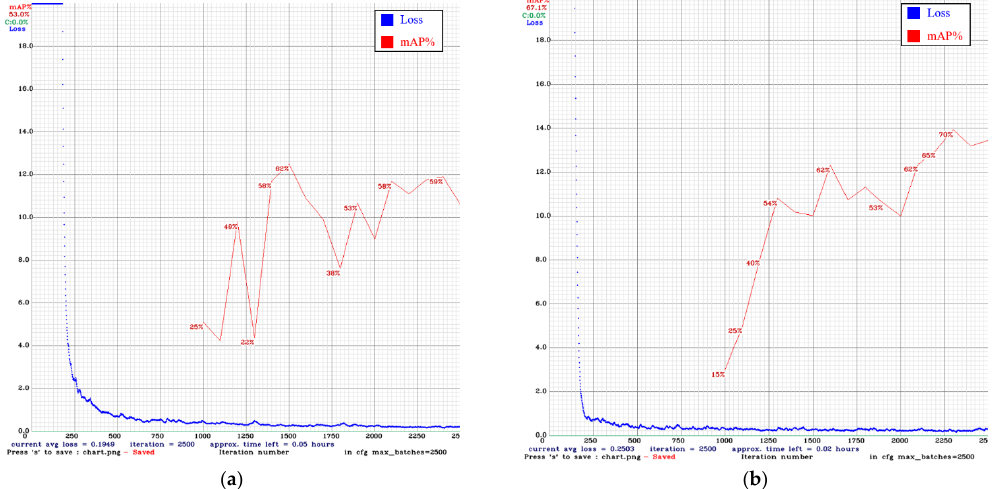
Figure 24. Training results for YOLO v3: ( a ) original images only ( b ) original images plus DCGAN synthetic images.